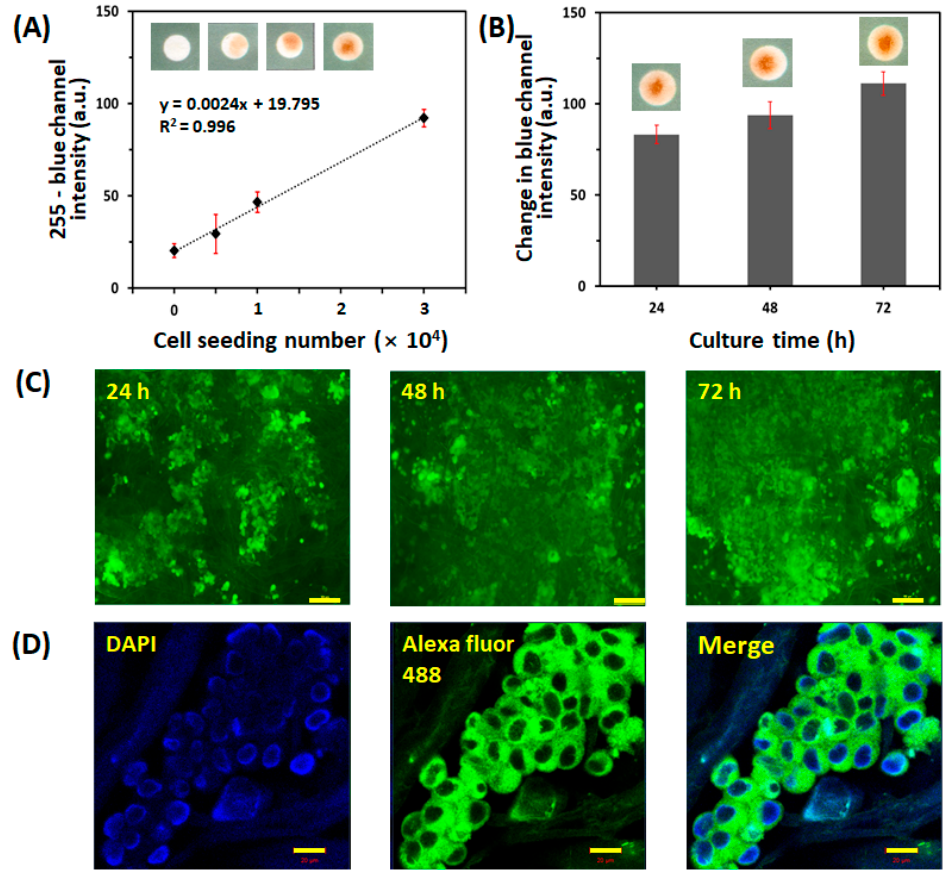
Figure 2. Characterization of the paper-based 3D cell culture platform. ( A ) Correlation between WST color intensity (255-blue channel intensity) and number of LNCaP cells (0, 5.0 × 10 3 , 1.0 × 10 4 , and 3.0 × 10 4 cells/zone) seeded onto the cell culture paper. The evaluation was carried out in three detection zones of three different papers ( n = 3). The error bars represent standard deviations (SD). ( B ) Proliferation of LNCaP cells cultured on the cell culture paper assessed using the WST assay. Initially, 3.0 × 10 4 cells/zone were seeded and cultured for 72 h. The proliferation of LNCaP cells was quantified at 24, 48, and 72 h using the change in blue channel intensity of WST. The evaluation was carried out in nine detection zones of three different papers ( n = 9). The error bars represent SD. ( C ) Representative fluorescence images of LIVE/DEAD™ staining of LNCaP cells cultured on the paper for 24, 48, or 72 h. The scale bar represents 100 µ m. ( D ) Representative image of immunofluorescence staining for PSA (green) in LNCaP cells after 72 h of culture on the paper. The scale bar represents 20 µ